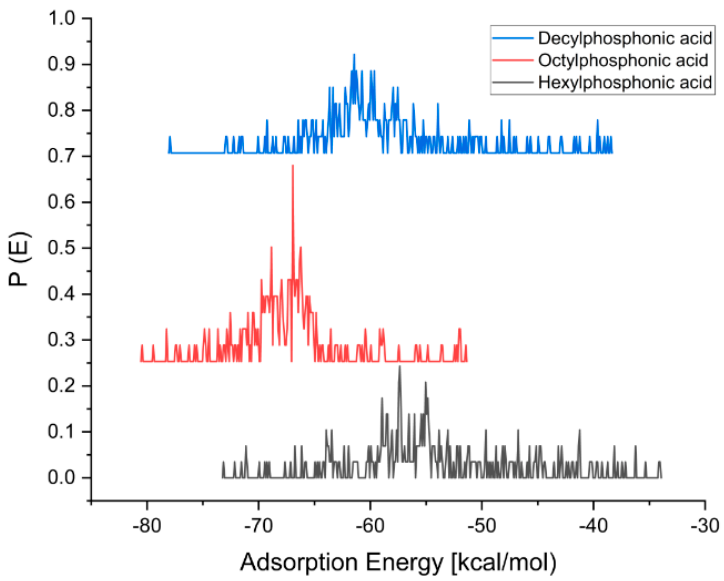
Figure 9. The adsorption energy of hexyl-, octyl- and decylphosphonic acids on the Cu (111) surface in ethanol medium.